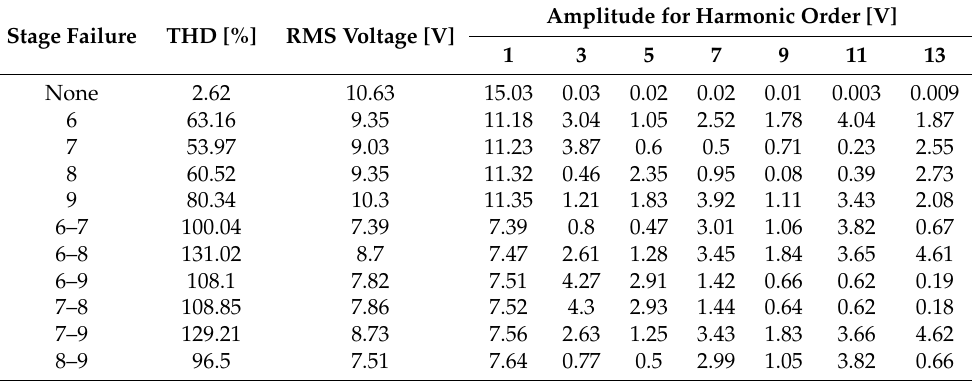
Table 1. THD, RMS voltage and amplitude of harmonic components for different inverter failures. Stage